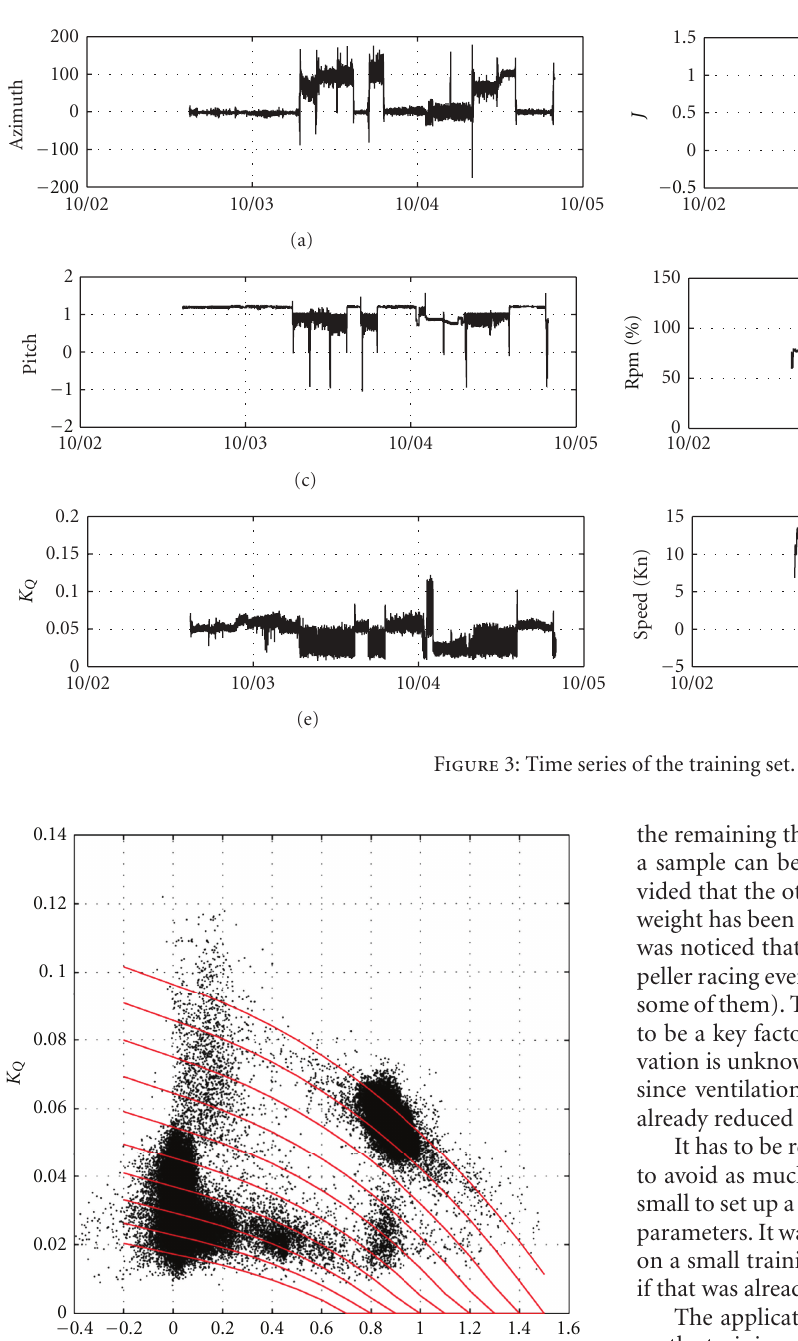
Figure 4: Torque coe ffi cient against advance